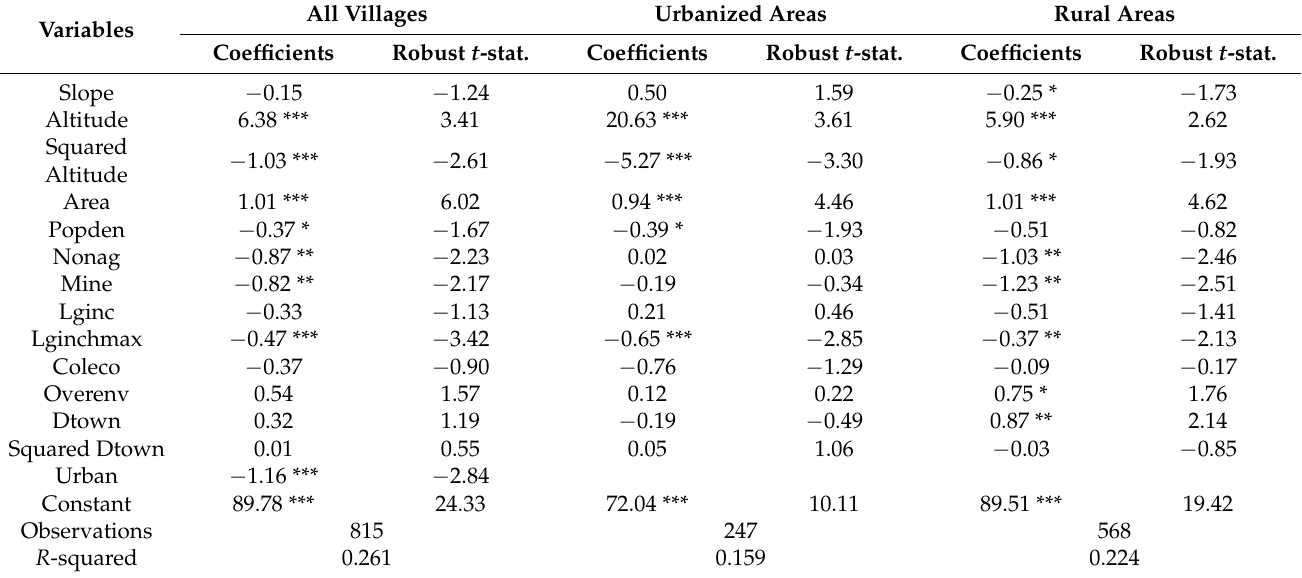
Table 5. Regression results of econometric